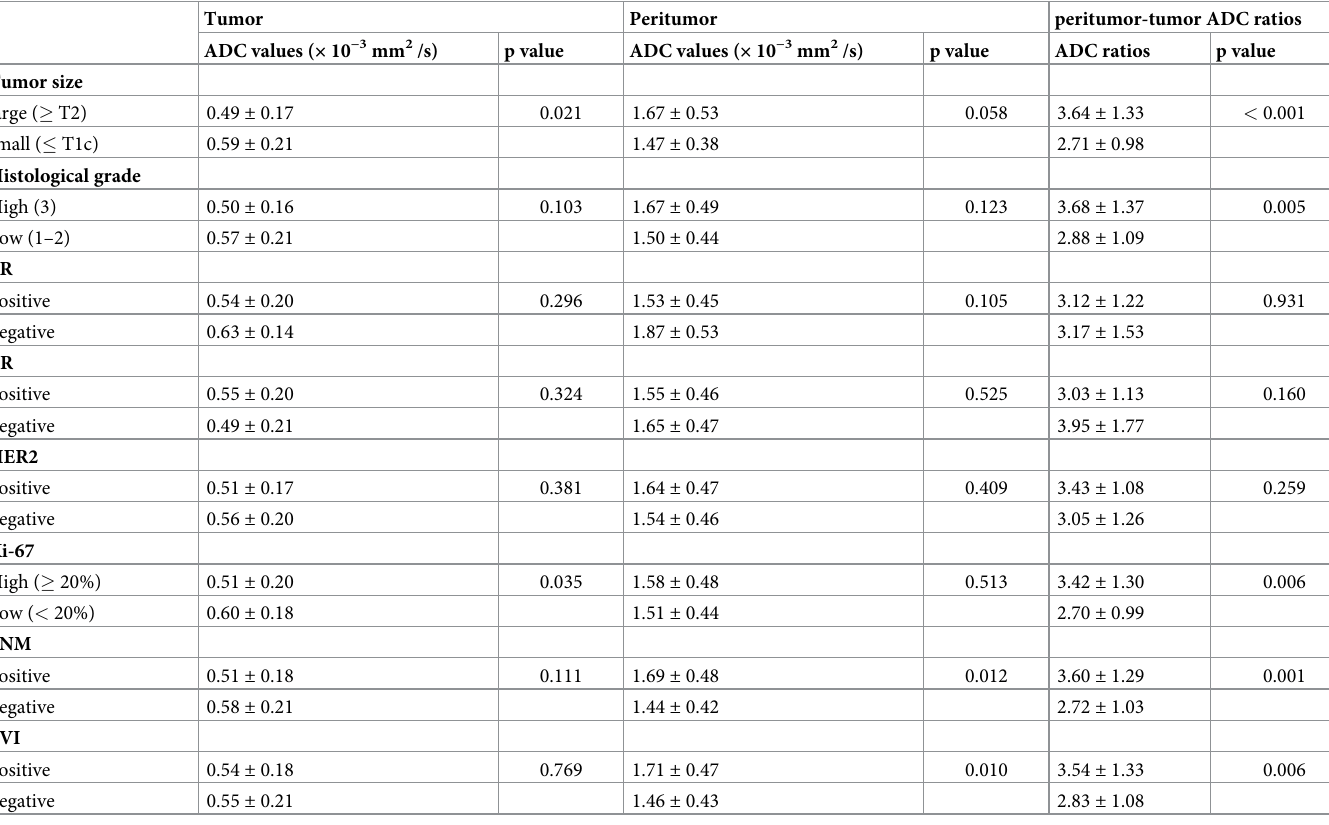
Table 4. Associations between tumor and peritumor ADC values, peritumor/tumor ADC ratios, and histopathological parameters.